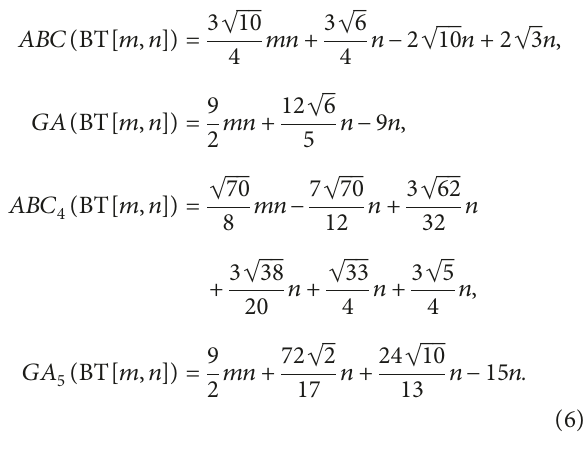
Figure 2. We categorize the boron- α nanotubes into two classes with respect to m . We denote these classes as